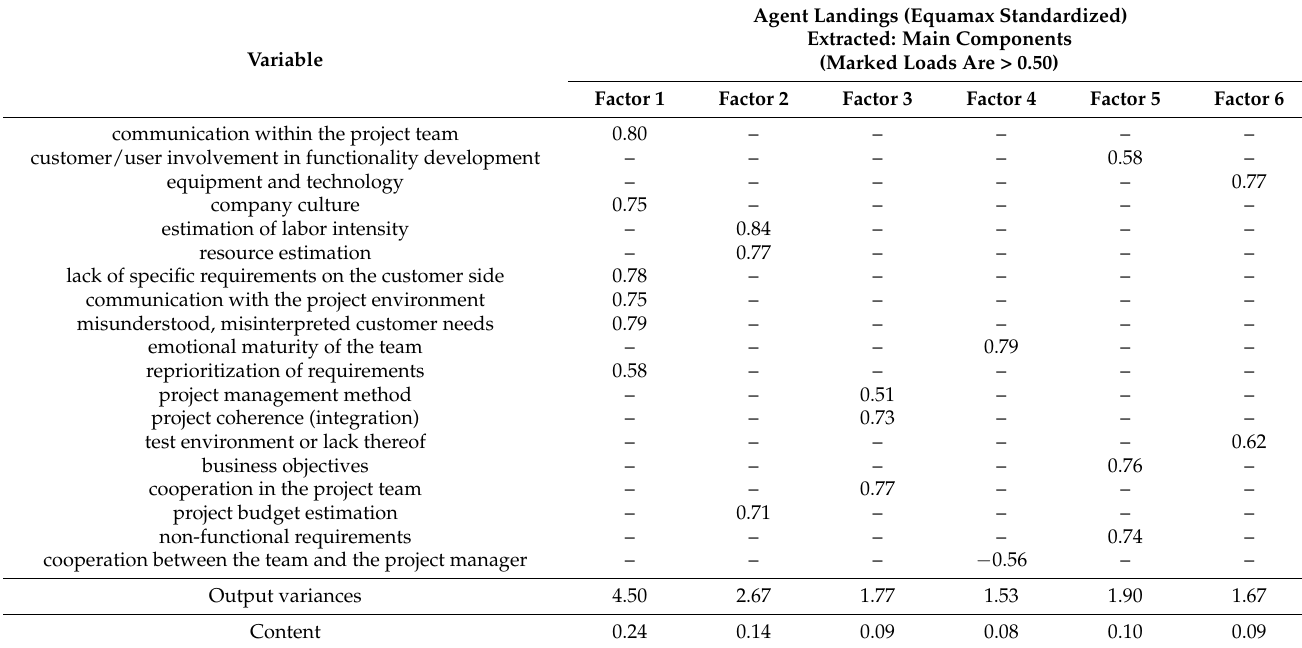
Table 5. Matrix of rotated components by the EQUAMAX